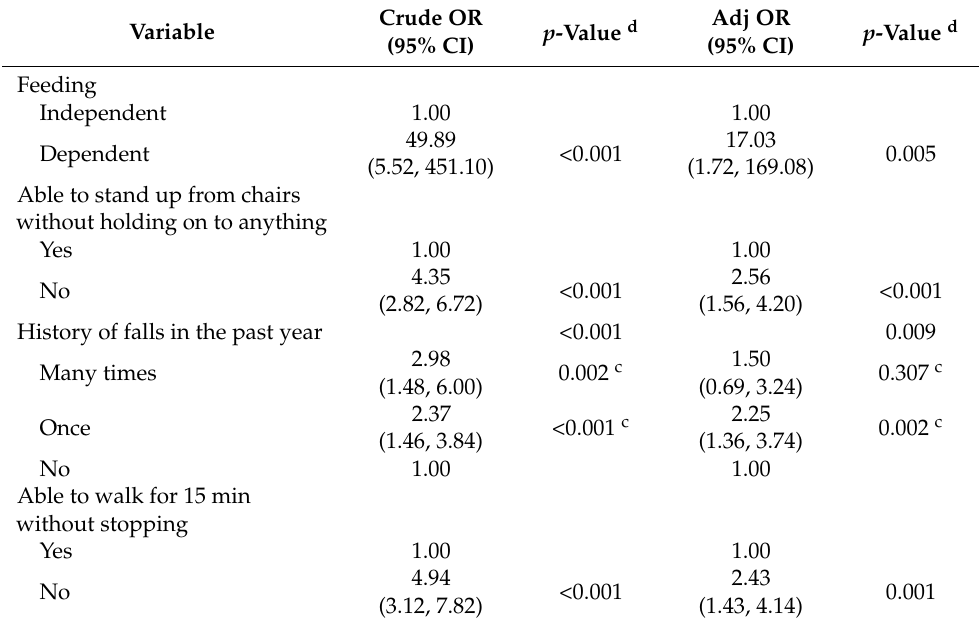
Table 4. Daily living activities associated with the need for